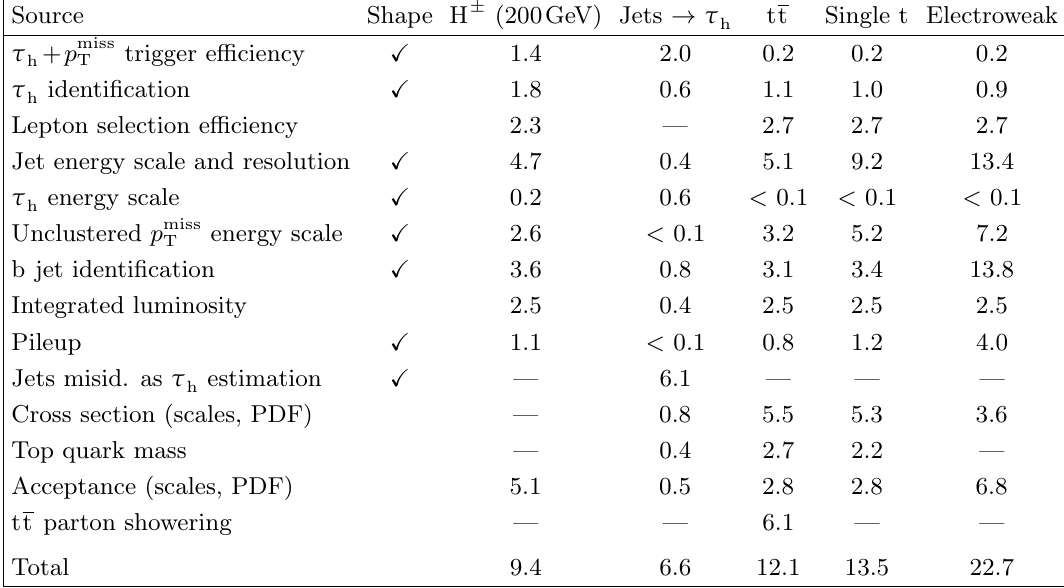
Table 2 . E(cid:11)ect of systematic uncertainties on the (cid:12)nal event yields in per cent, prior to the (cid:12)t, summed over all (cid:12)nal states and categories. For the H (cid:6) signal, the values for m